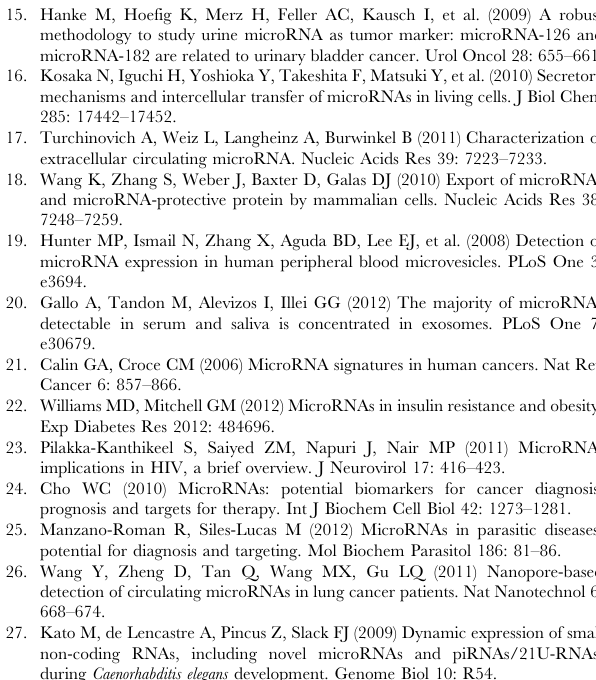
Table S5 Human miRNA candidate sequences identified by deep-sequencing. Table S6 Onchocerca volvulus miRNA candidate sequences identified by deep-sequencing. Table S7 Detailed RT-qPCR information for miR-71. Table S8 Detailed RT-qPCR information for miR-34. Table S9 Detailed RT-qPCR information for